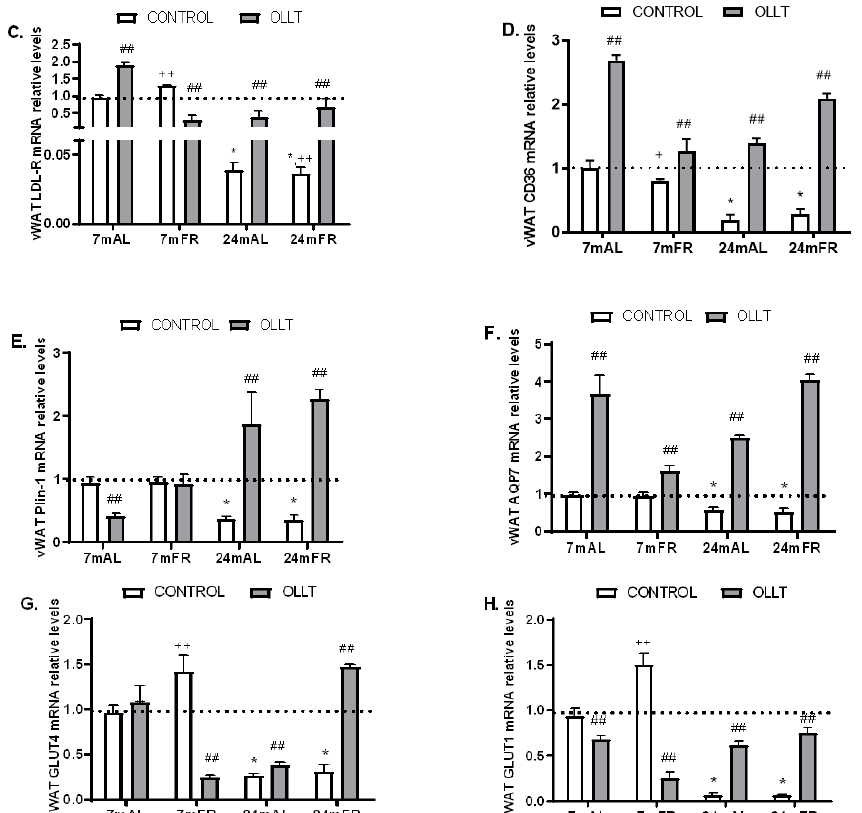
Figure 7. mRNA relative levels of PPARγ ( A ), LPL ( B ), LDL-R ( C ), CD36 ( D ), Plin-1 E ), AQP7 ( F ), GLUT4 ( G ), and GLUT1 ( H ) in the visceral adipose tissue in the 7- and 24-month-old rats fed ad libitum (AL) or food-restricted (FR), before (CONTROL) and after an oral lipid loading test (OLLT). Results are the mean ± SEM of 8–10 rats per group, conducted in duplicates. Unpaired Student’s t -test, * p < 0.05 compared to the 7-month-old rats under the same feeding protocol; + p < 0.05, ++ p < 0.0001 compared to the age-matched ad-libitum-fed rats; ## p < 0.0001 compared to the basal levels before a fat load of the age-matched rats under the same feeding protocol.